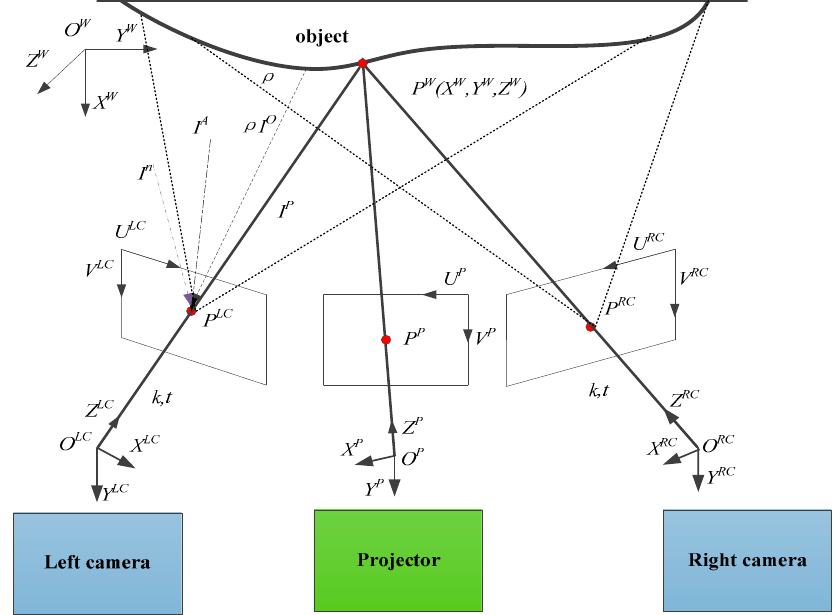
Figure 2. Schematic diagram of binocular fringe projection system, (1) the ambient light coming directly to the camera sensor with an intensity of I A , (2) the projected light with an intensity of I P , reflected by the object with surface reflectivity of ρ , ρ I P , (3) the ambient light with an intensity of I O , reflected by the object, ρ I O , (4) let the camera sensitivity be k , the exposure time be t , (5) the noise of the sensor is I n , generally obeys Gauss distribution, I n ∼ N 0, σ 2